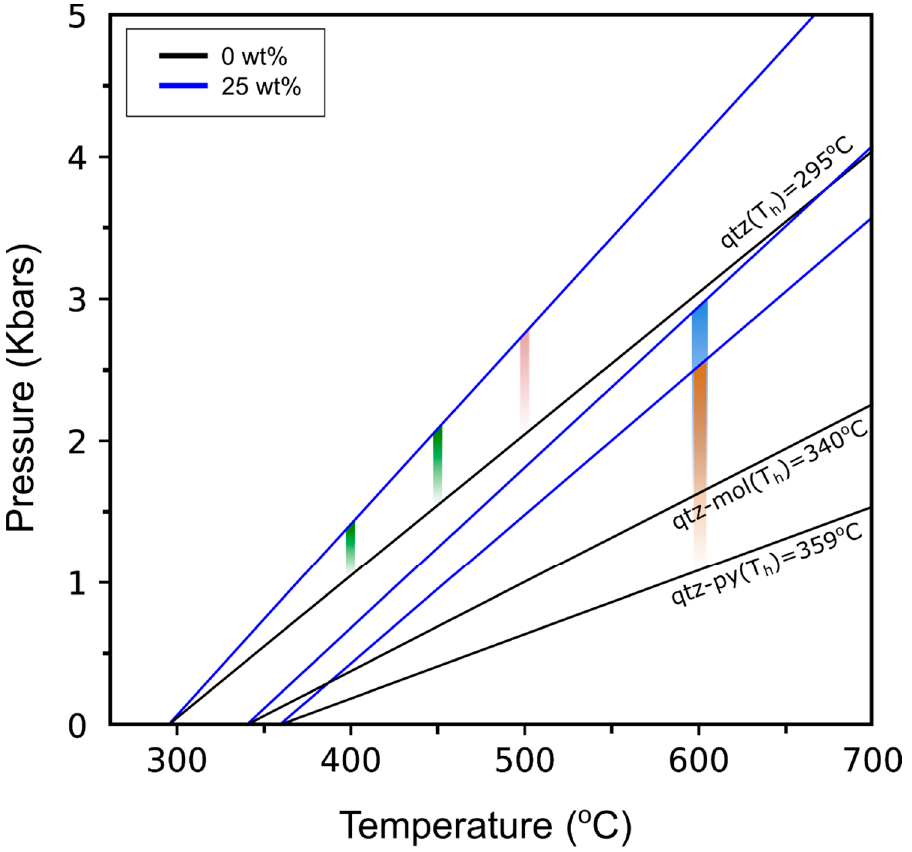
Figure 10. Estimated pressures of vein formation at the Erdenet deposit. Temperatures are derived from the Ti-in-quartz geothermometer, and the isochores correspond to salinities of 0–25 wt% [35].